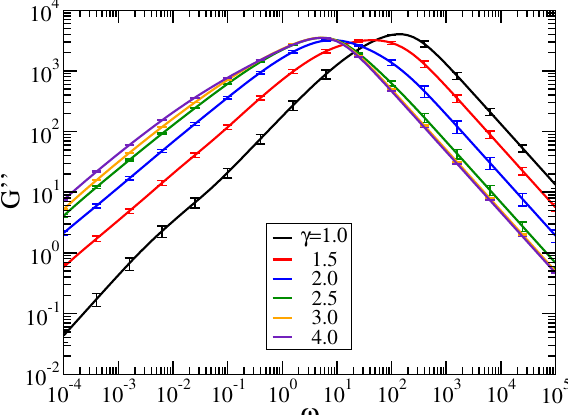
Figure 6. Loss modulus for pDSFNs with N = 10,000, p = 0.01, and various values of γ . The frequency ω has units of σ = K / ζ . Error bars show the standard errors.